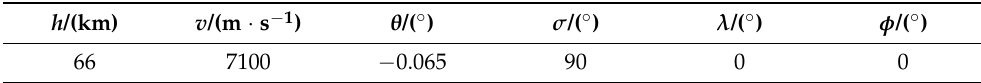
Table 1. The initial state of the vehicle.